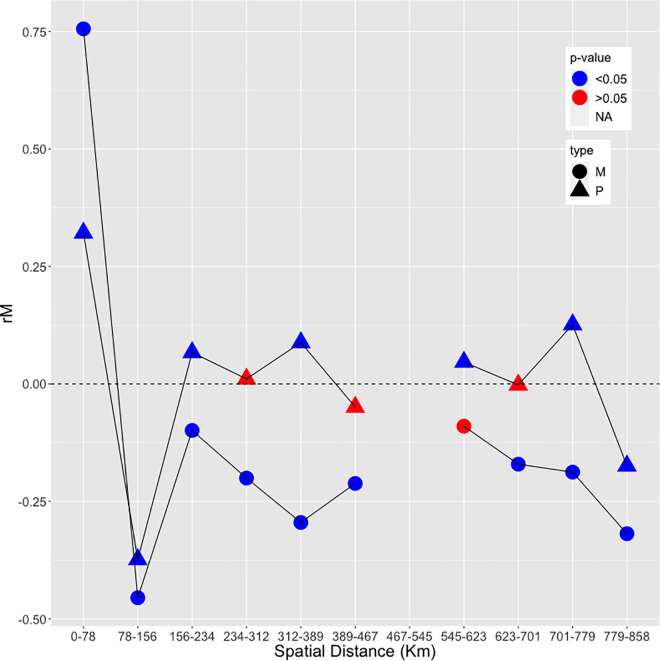
Mantel Correlogram for genetic and geographic (euclidean) distance.The value of Mantel correlation coefficient is shown for each distance class. Circles (M) correspond to result of Mantel correlogram without controlling for interaction with network distance. Triangles (P) indicate correlation analyses taking into account potential interaction with the network distance Netdist (see main text). Colors indicate significance of the Mantel tests. Results of other correlograms based on different geographical and network-related distances are shown in S4 Fig.